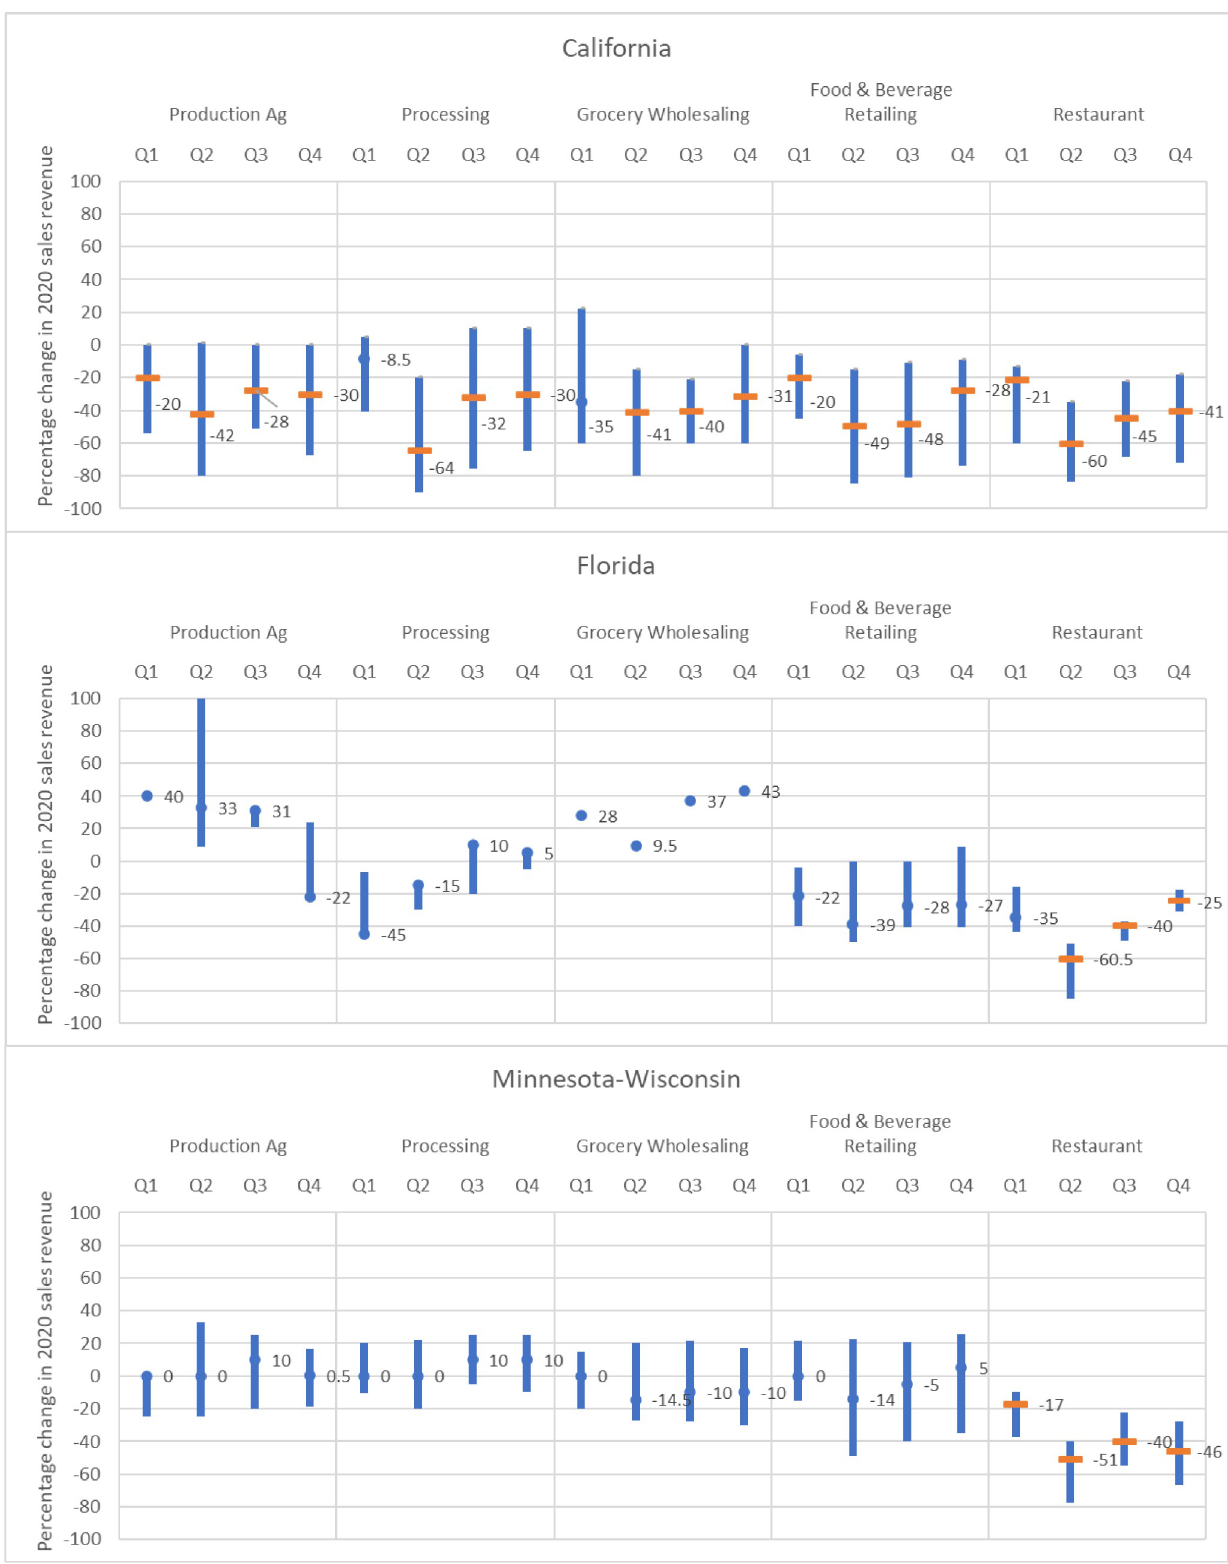
Fig 1. Quarterly changes to business sales revenue relative to pre-pandemic levels, 2020 a . a Bars represent 75th and 25th percentiles of responses. Numbers indicate the median value. Wide ticks represent statistical significance at the 5% level. Sample sizes are reported in Table 4.